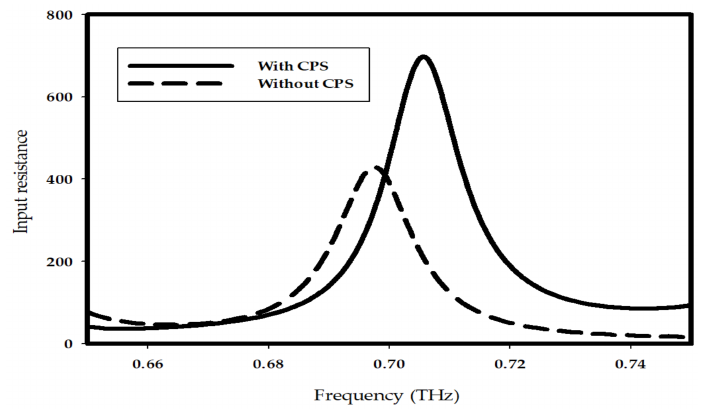
Figure 9. Input resistance of photomixer based slot fed THz DRA with or without